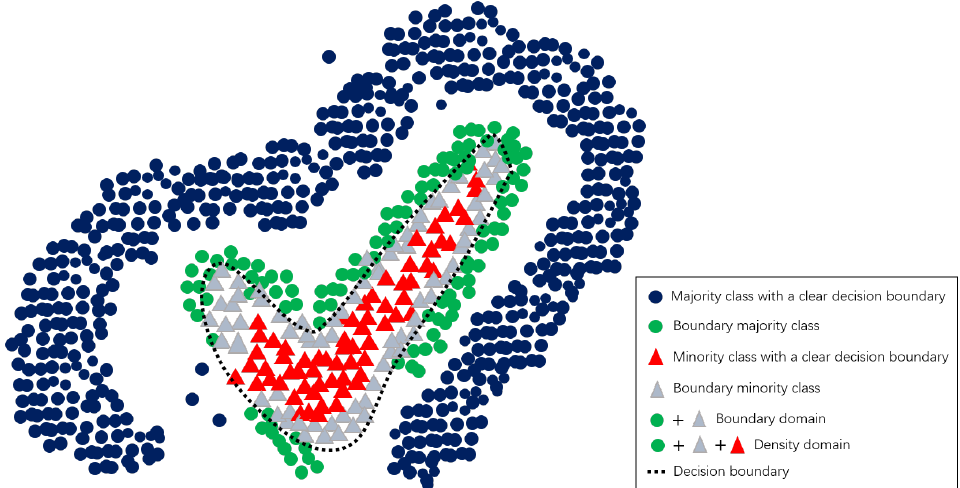
Figure 1. Illustrative diagram of the process for determining boundary samples. Here, the triangles represent the minority class samples and the circles represent the majority class samples. The blue circles are the majority class with a clear decision boundary, and the red triangles are the minority class with a clear decision boundary. The gray triangles indicate the boundary minority samples, i.e., the boundary domain. The green circles indicate the boundary majority class samples. The red triangles, gray triangles, and green circles constitute the overall density